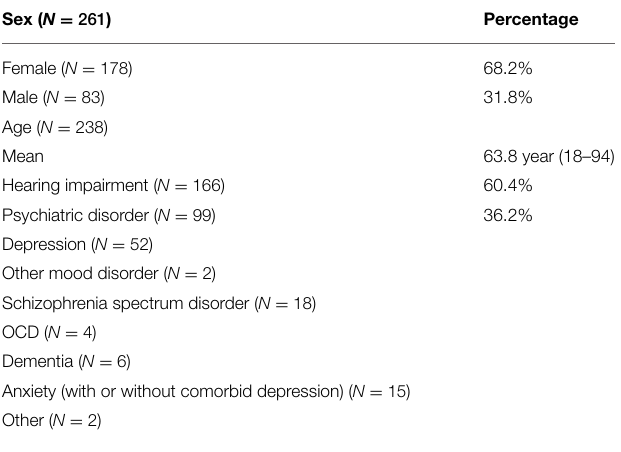
TABLE 1 | Clinical features of 276 patient with musical